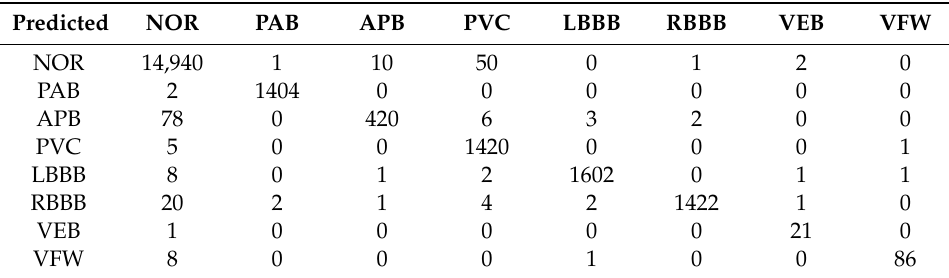
Table 5. Confusion matrix of the proposed CNN-LSTM model.